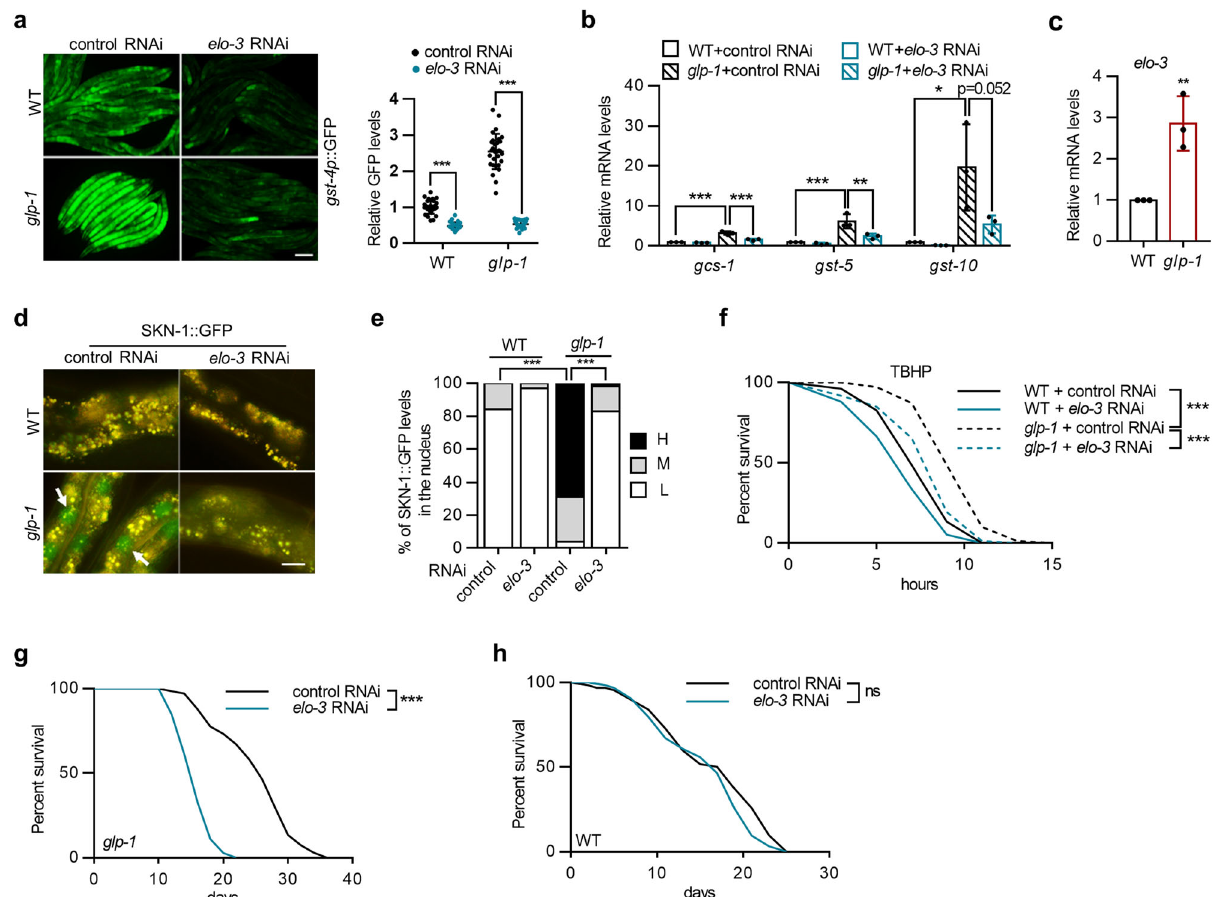
Fig. 1 ELO-3 regulates SKN-1 activation and longevity in response to germline loss. a Effects of elo-3 RNAi treatment on the expression of gst-4p ::GFP